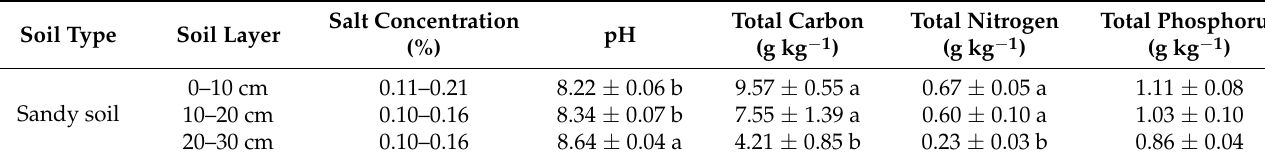
Table 1. The basic physical and chemical properties of the field soil. The measurement methods were according to Lu [23]. Values are the mean ± standard error. Values for each column followed by different letters denote a significant difference among different treatments according to Duncan’s new multiple range test ( p <